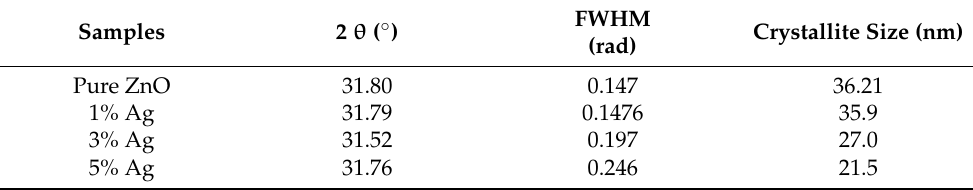
Table 1. Calculation of the crystallite size of ZnO and Ag-doped ZnO thin films.